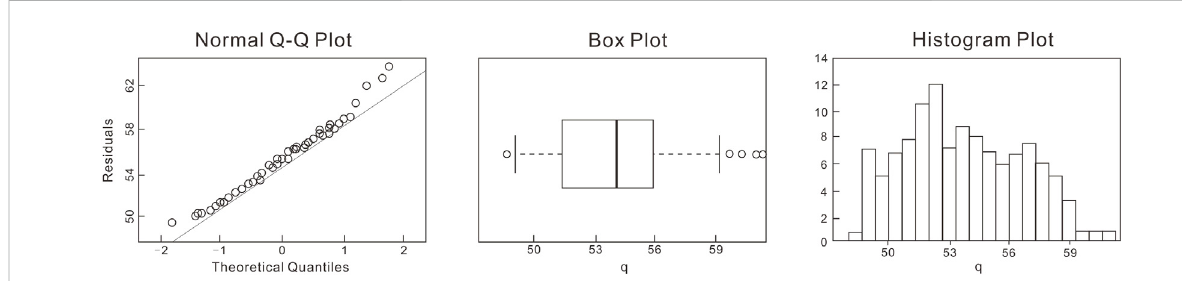
FIGURE 9 Diagnostic plots for all 64 successful two-level Full Factorial design simulation runs.